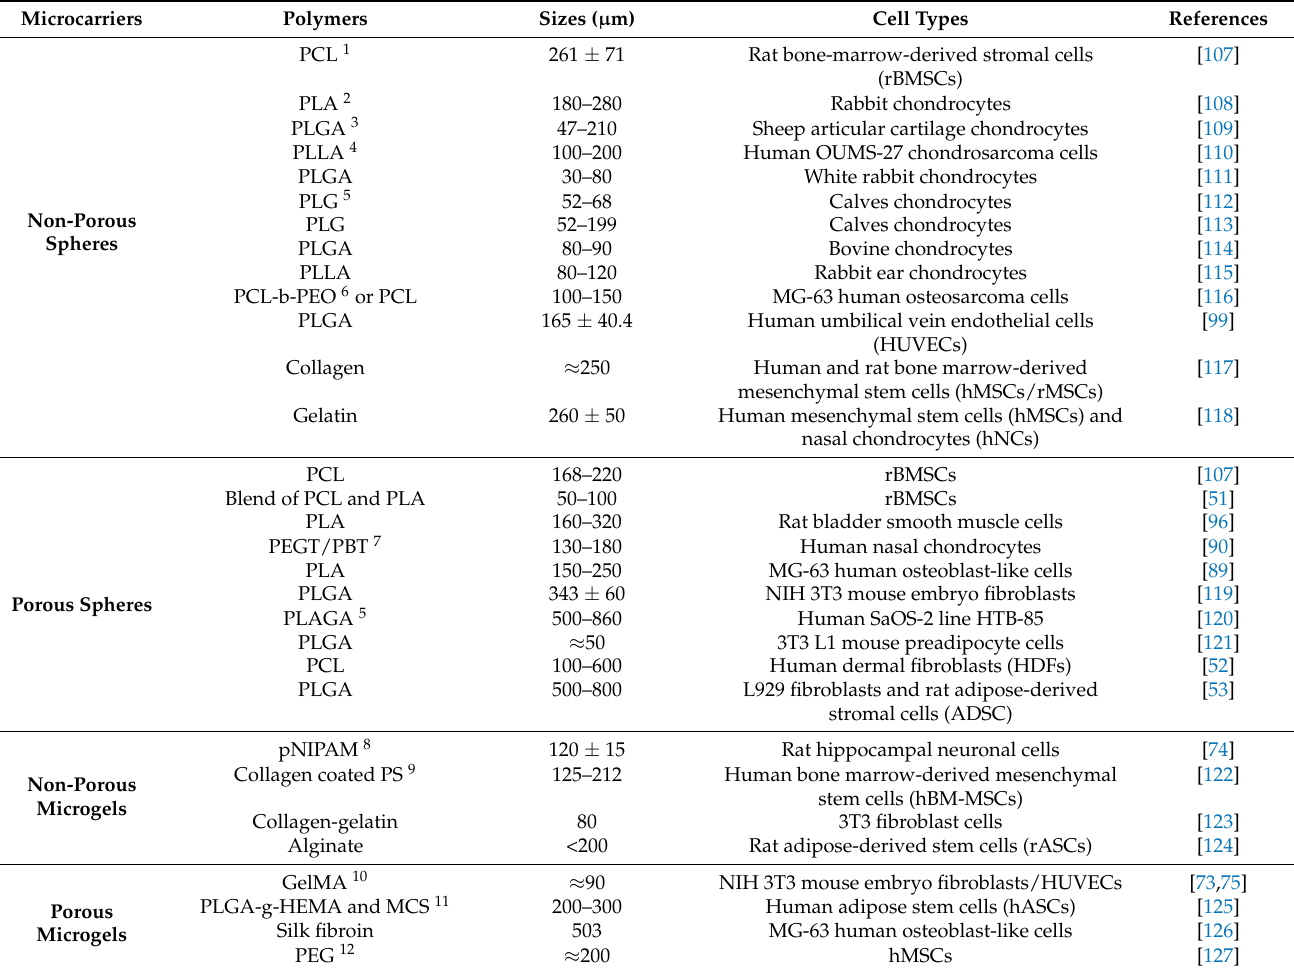
Table 2. Summary of commonly used polymeric materials as porous and non-porous spherical and microgel microcarriers of particular sizes together with respective cell